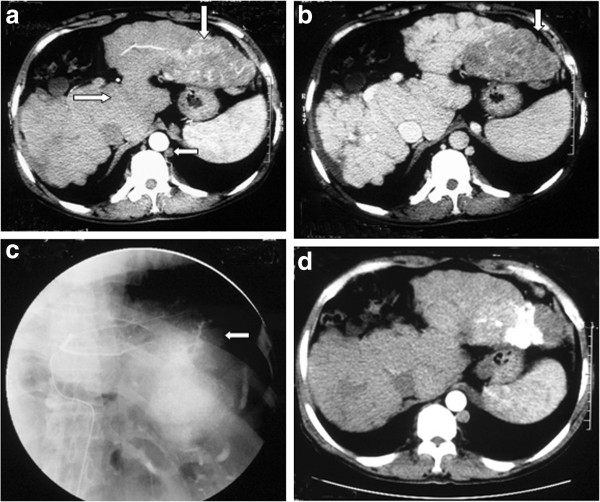
50-year-old man with HCC in BCS. (a) Contrast-enhanced transverse CT scan showing a large heterogeneous enhanced nodule (⇩) in the left liver during arterial phase, and enlarged caudate lobe (⇨), cirsoid semi-azygous vein (⇦), and liver cirrhosis. (b) Washout of the nodule on portal venous phase (⇩). (c) Angiography showing heterogeneous, contorted and enlarged tumorous vein and tumor staining in the left liver (⇦) during arterial phase. TACE was given. (d) CT scan showing that the nodule was obviously shrinked and obtained stable effect 2 months after TACE treatment. Lipiodol was not located equably in the nodule.